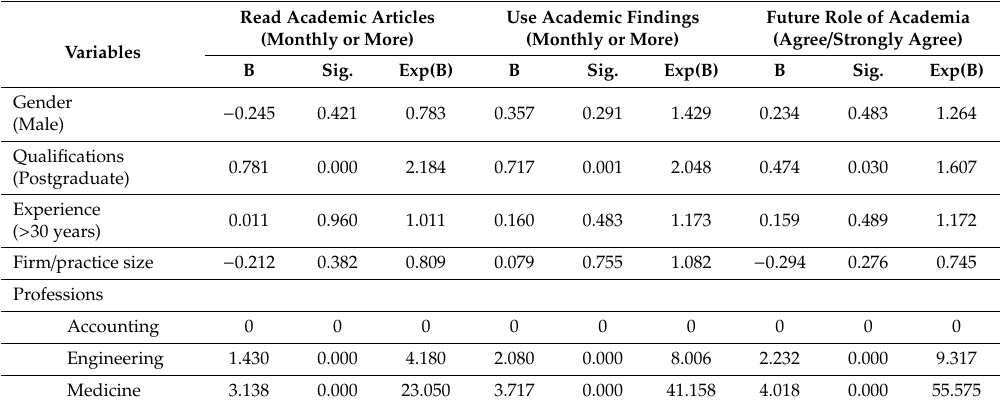
Table 8. Analysis of data combining the three